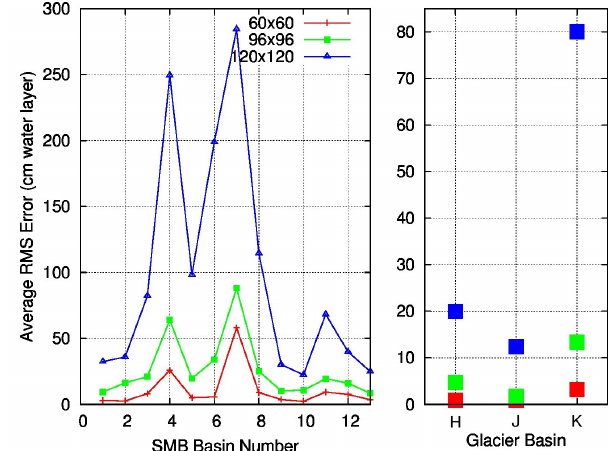
Figure 9. Average RMS error per basin for the noise-only simula- tions, for data of increasing maximum degree, in SMB basins and glacial basins. Yearly windowing